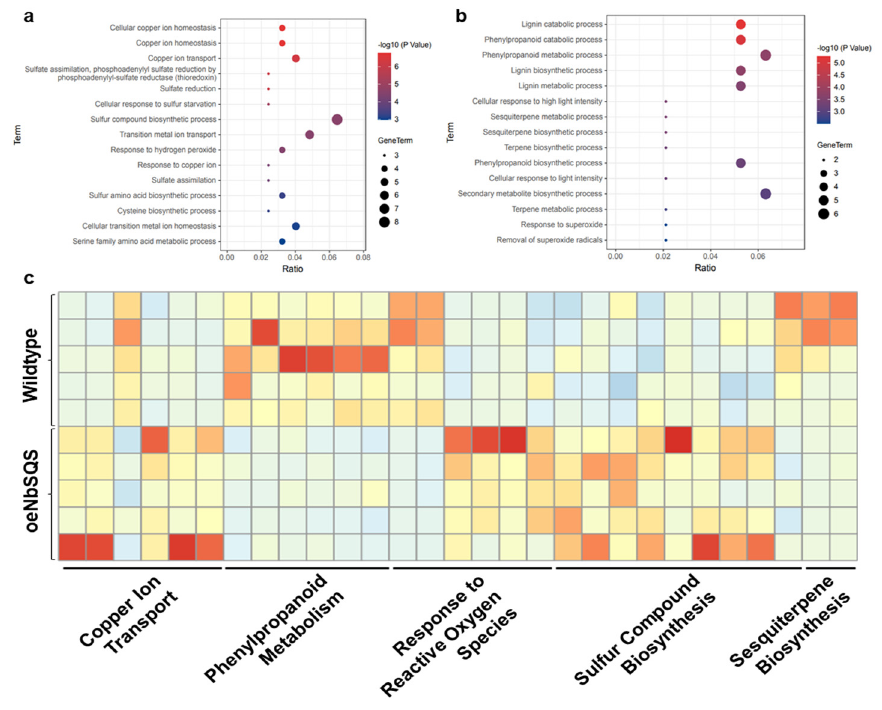
Figure 6. Comparative transcriptomic analysis of wild type and SQUALENE SYNTHASE ‐ overex ‐ pressing N. benthamiana leaves. Gene ontology enrichment analysis results of up ‐ regulated ( a ) and down ‐ regulated ( b ) genes in oeNbSQS plants. Normalized expression heatmap of differentially ex ‐ pressed genes belonging to the gene ontology terms ( c